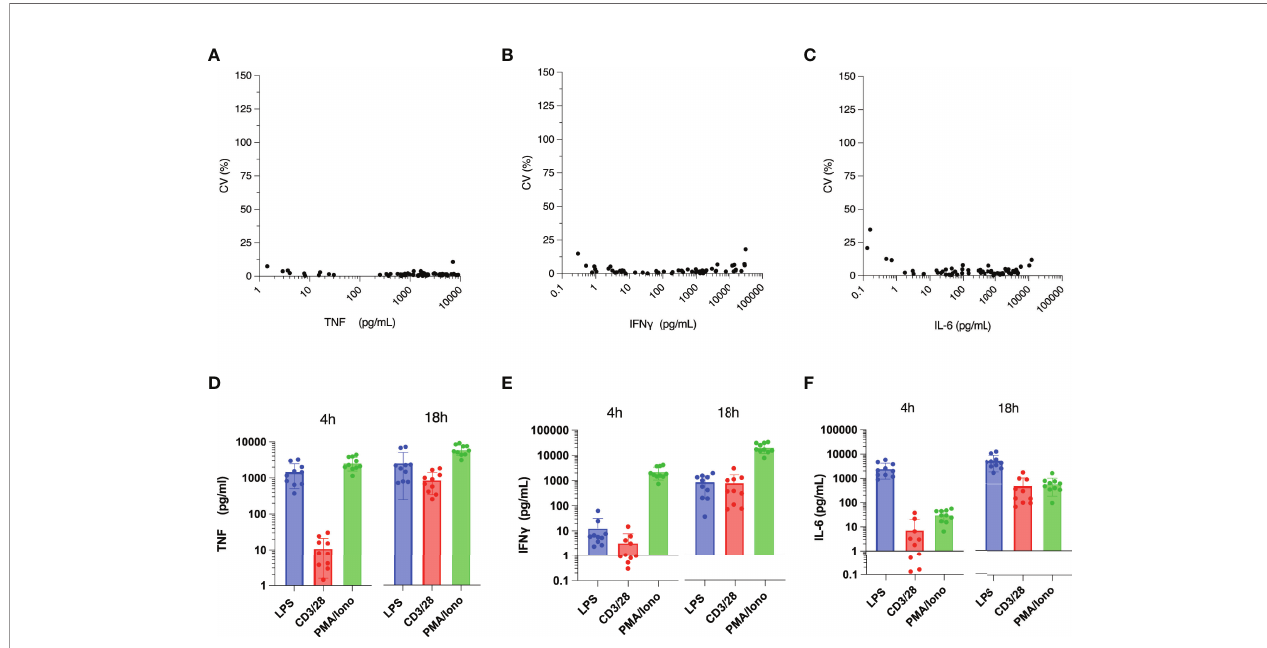
FIGURE 2 | Intra-assay variability of ELLA micro fl uidic immunoassay, assessed by percentage coef fi cient of variation (CV) for: (A) Tumor Necrosis Factor (TNF), (B) Interferon (IFN) g , and (C) Interleukin (IL)-6. (D) TNF, (E) IFN g , and (F) IL-6 production following ex vivo stimulation with various immune stimulants (x-axis) for 4 hours or 18 hours. N = 3 for each measured analyte.